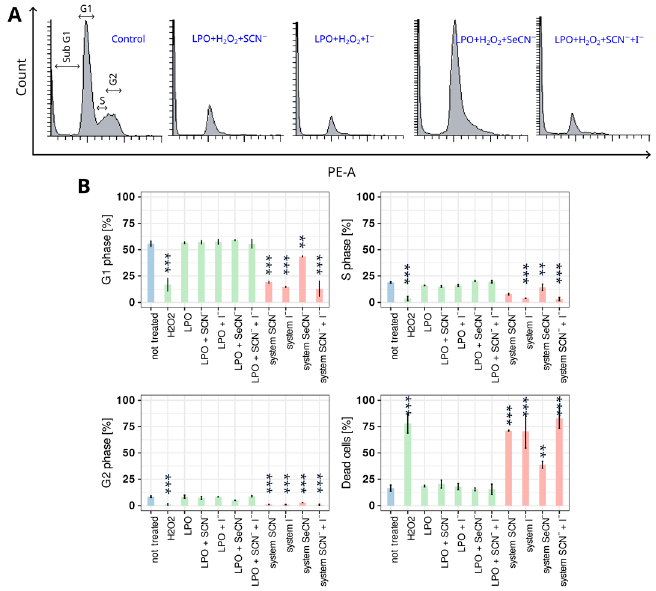
Figure 2. Influence of tested systems on the percentage of cells in each analysed cell cycle phase. ( A ) Rep- resentative histograms of cell cycle distribution in the control sample and samples treated with all tested active LPO systems. ( B ) Percentage (mean) of cells in each cell cycle phase. Colours indicate sample types where (i) blue denotes the control, (ii) green denotes an inactive LPO system (enzyme + (pseudo)halide), and (iii) red denotes an active LPO system. Asterisks indicate a statistically significant difference between a tested group and the control in the post hoc Tukey’s test—** p < 0.01; *** p <